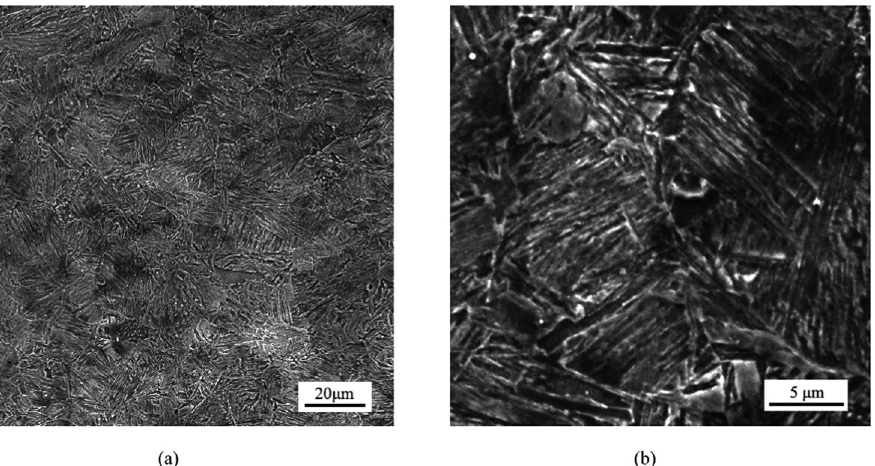
Figure 11: SEM image of the specimen subjected to CHT with decreasing holding times at temperature of 960°C: ( a ) 1,000 × and ( b ) 5,000 ×